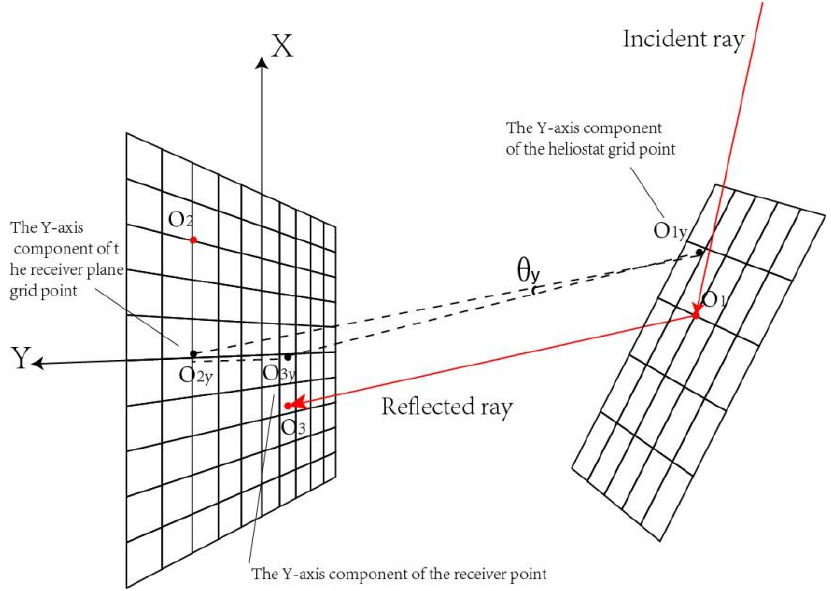
Figure A3. The included angle between the reflected ray of each grid and O 1 O 2 in the Y-direction under the elliptic Gaussian